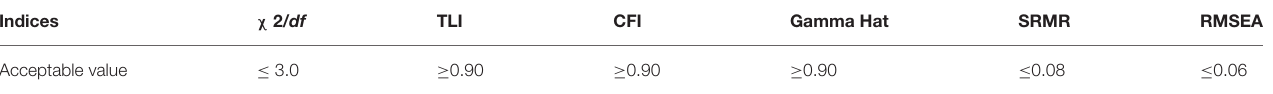
TABLE 1 | Benchmarks of Goodness-of-Fit indices. Indices χ 2/ df TLI CFI Gamma Hat SRMR RMSEA Acceptable value ≤ 3.0